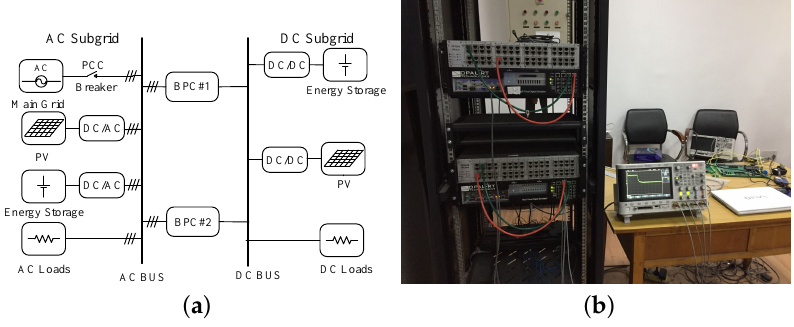
Figure 11. ( a ) Hardware-in-loop tests topology; and ( b ) Hardware-in-Loop (HIL) test